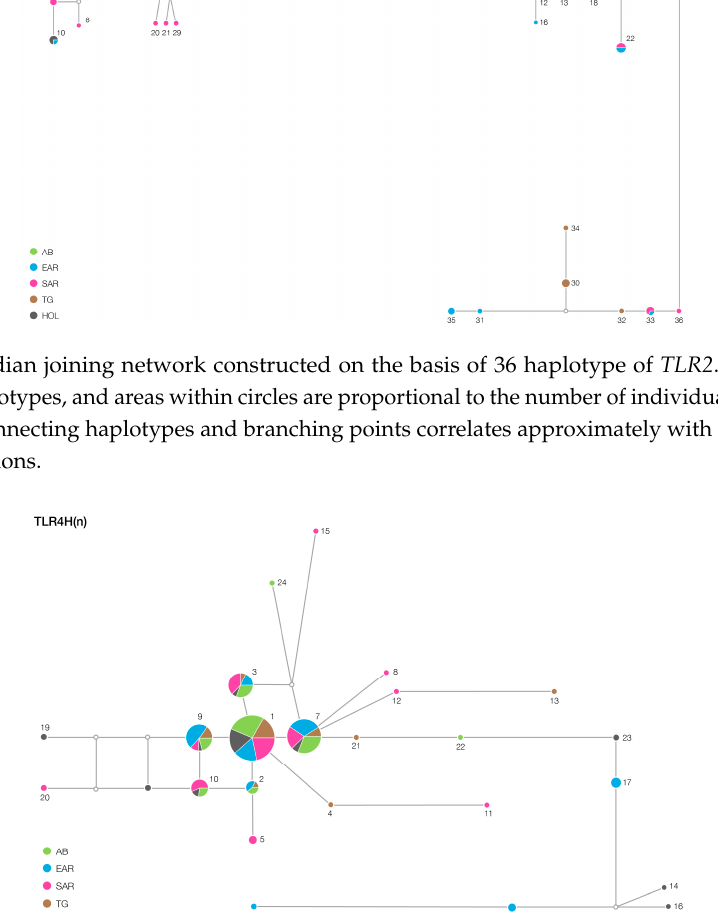
Figure 5. Median joining network constructed on the basis 25 haplotype of TLR4. Filled circles represent haplotypes, and areas within circles are proportional to the number of individuals. The length of the lines connecting haplotypes and branching points correlates approximately with the number of base substitutions. Table 3. Missense and synonymous variations on protein domain level of TLR2 (according to reference sequence NP_776622.1).